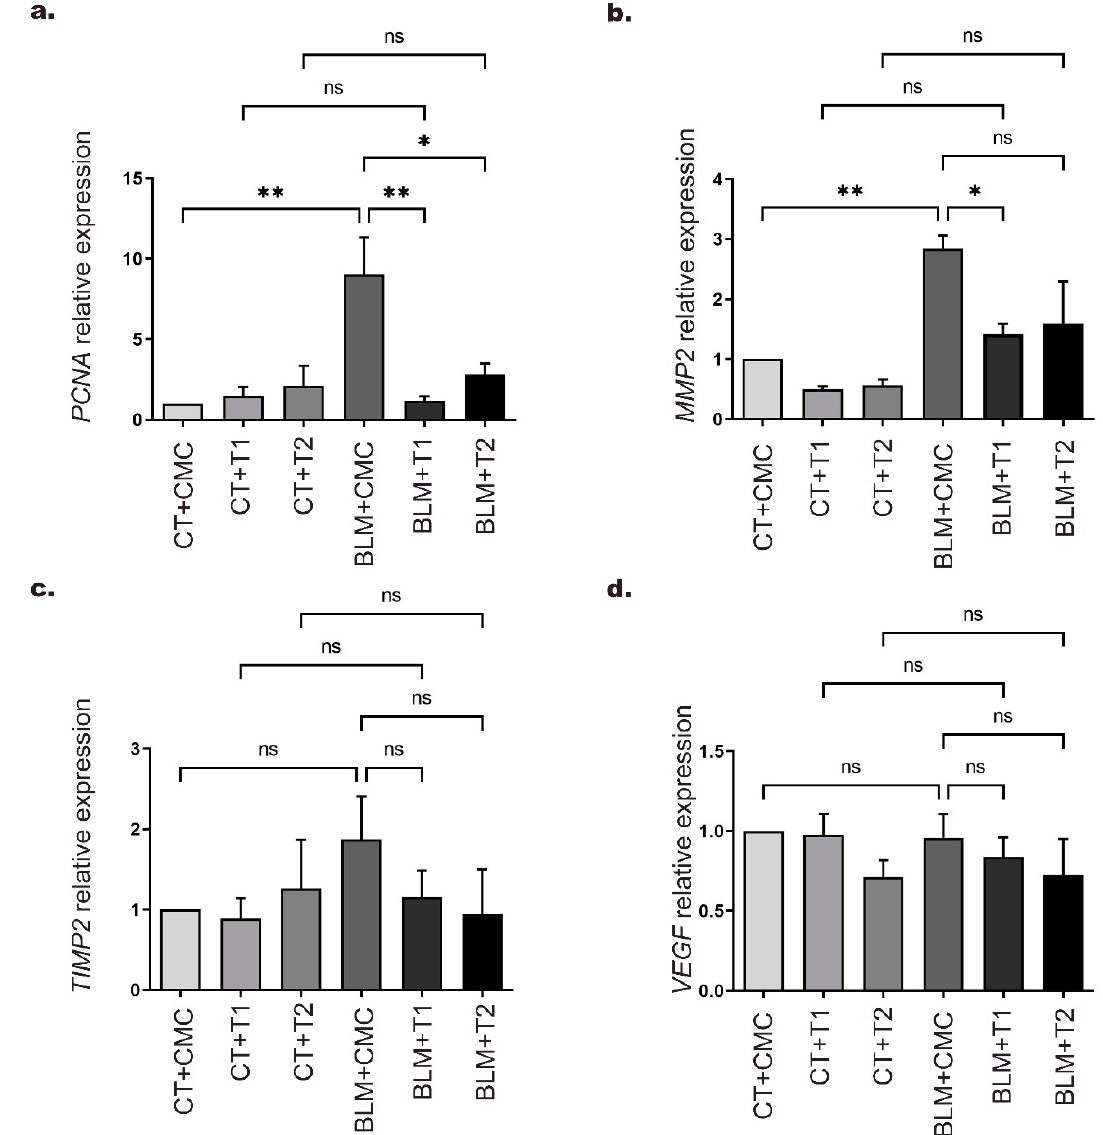
Figure 4. 3 ′ 5-DMBA modulates the expression of genes related to cell proliferation and remodeling of the ECM during its antifibrotic effect. Mice in BLM groups were instilled with an osmotic minipump loaded with BLM 100 U/kg. Mice in control groups (CT) have a sham instillation. On day 14, mice received either 3 ′ 5-DMBA or its vehicle intragastrically until they were euthanized on day 28. The mRNA levels of ( a ) PCNA ; ( b ) MMP2 ; ( c ) TIMP2 ; and ( d ) VEGF , were determined in mouse lung tissue by real-time quantitative PCR (RT-qPCR). CT+CMC: control group, BLM+CMC: BLM-treated group, BLM+T1: BLM plus 3 ′ 5-DMBA-treated group at a dose of 6 mg/kg, and BLM+T2: BLM plus 3 ′ 5-DMBA-treated group at a dose of 10 mg/kg. Data are represented as the mean ± SD (n = 4). Data were analyzed by one-way ANOVA followed by Tukey’s t -test for comparison between groups. For each graph, the asterisks above the horizontal lines indicate significant differences with respect to their control groups and differences between the two doses and the vehicle. * p < 0.05, ** p < 0.01. BLM: bleomycin, CMC: carboxymethylcellulose (vehicle), and 3 ′ 5-DMBA: 3 ′ 5-dimaleamylbenzoic acid.